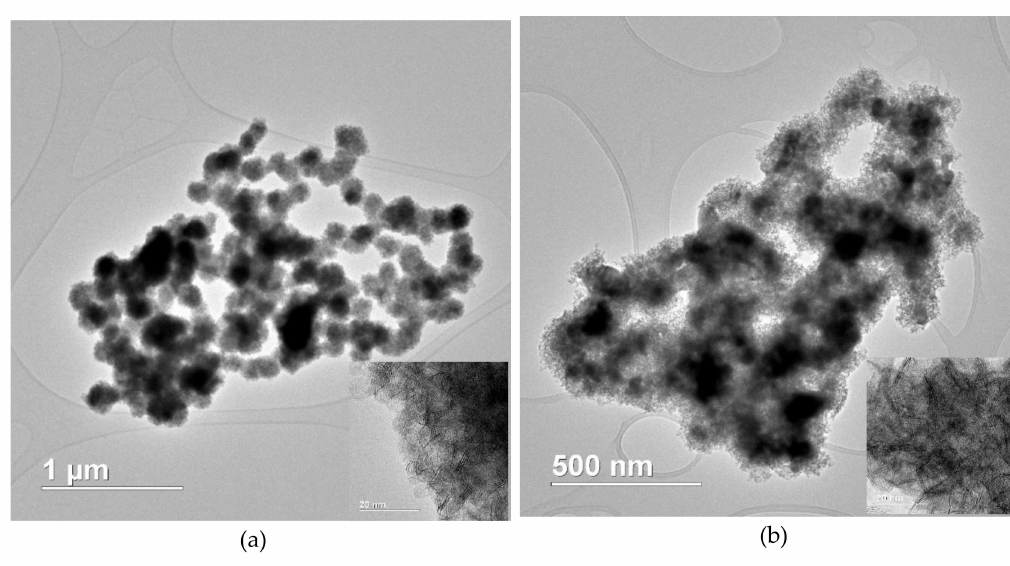
Figure 5. TEM micrograph of NiWS catalysts with ( a ) 0.5% and ( b ) 1% HY obtained in situ in standard